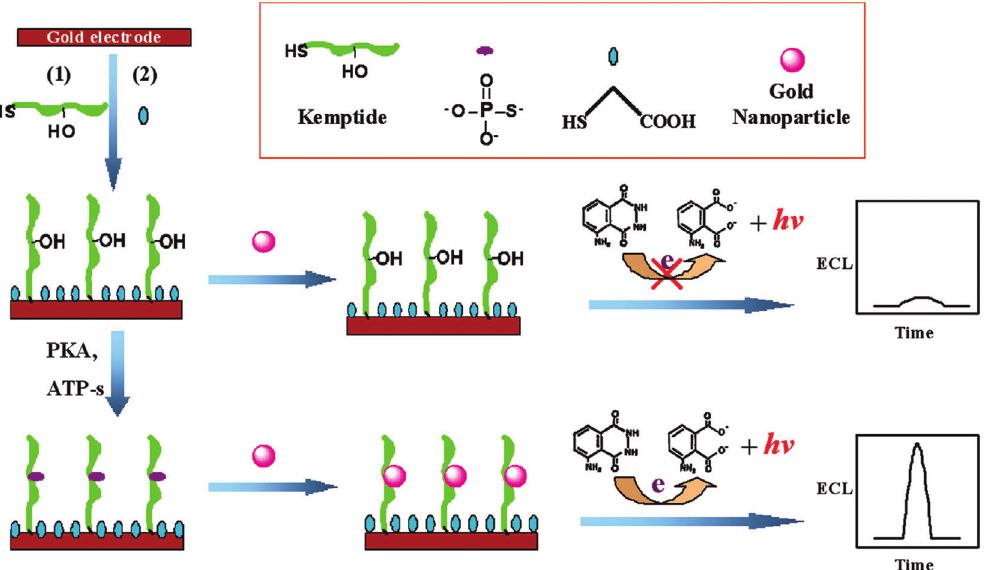
Figure 5 Schematic representation of ECL strategy for kinase activity detection using gold nanoparticles as signal transduction probes. Reprinted with permission from Xu et al. (2010). © 2010 American Chemical